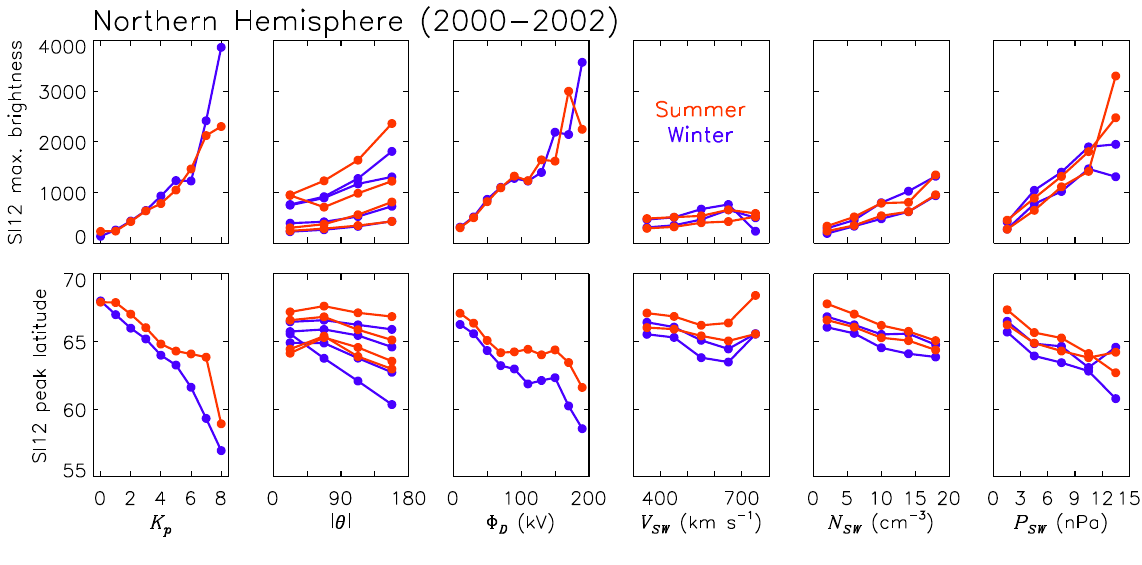
Fig. 6. Similar to Figs. 4 and 5, indicating the variation in the SI12 maximum nightside auroral intensity and the latitude of the peak in auroral brightness for the Northern Hemisphere observations (2000 to 2002), subdivided into summer months (red) and winter months (blue); see text for